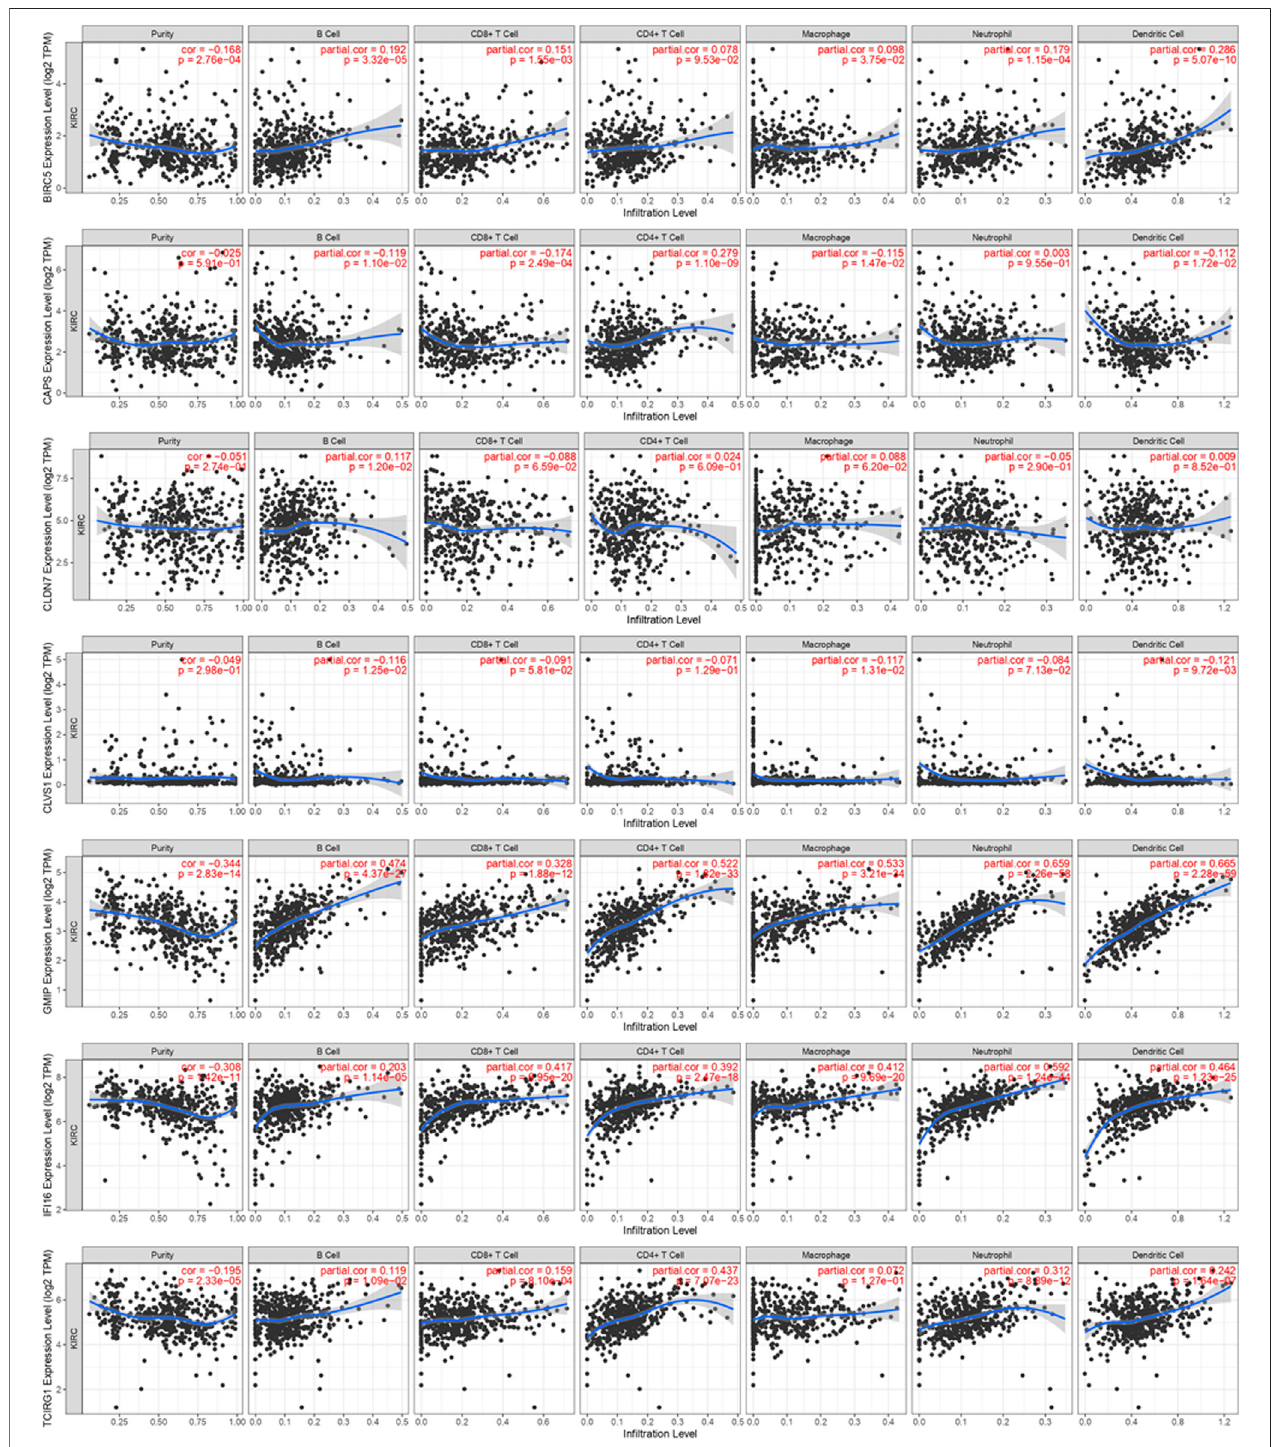
FIGURE 13 | Immune cell in fi ltration of 7 DEGs in TCGA-KIRC from TIMER.